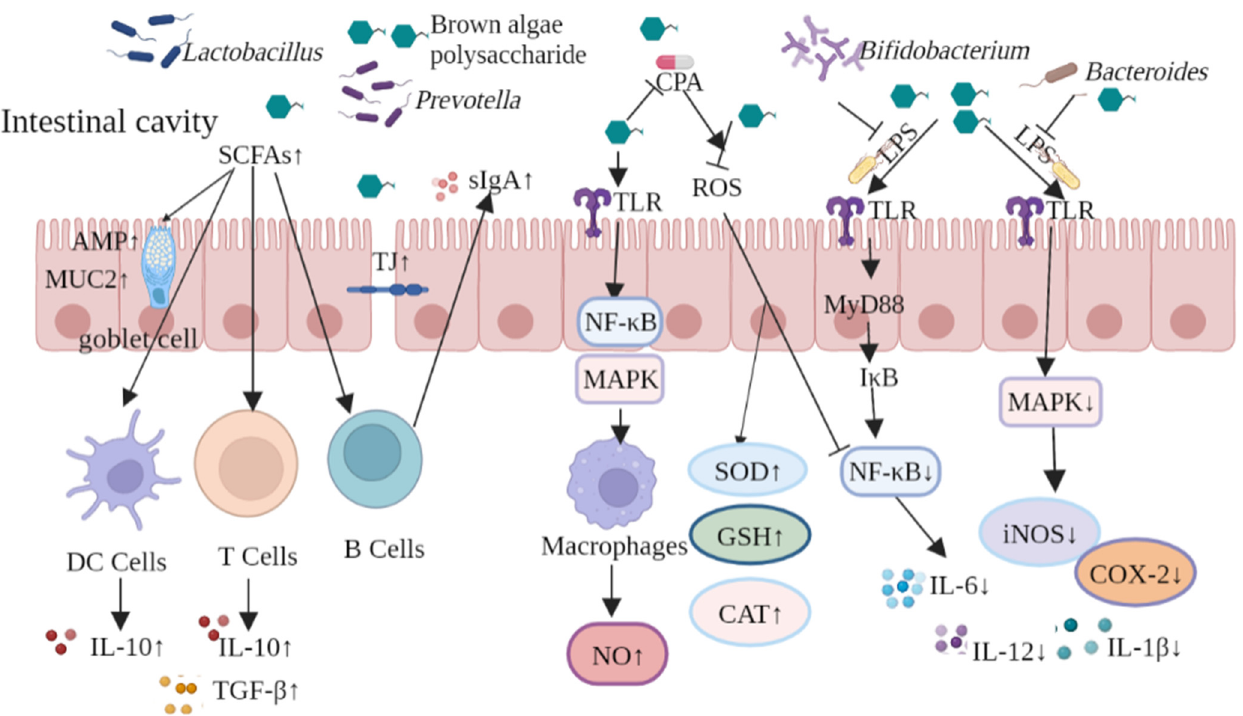
Figure 7. Protective mechanisms of brown algae-derived polysaccharides against intestinal